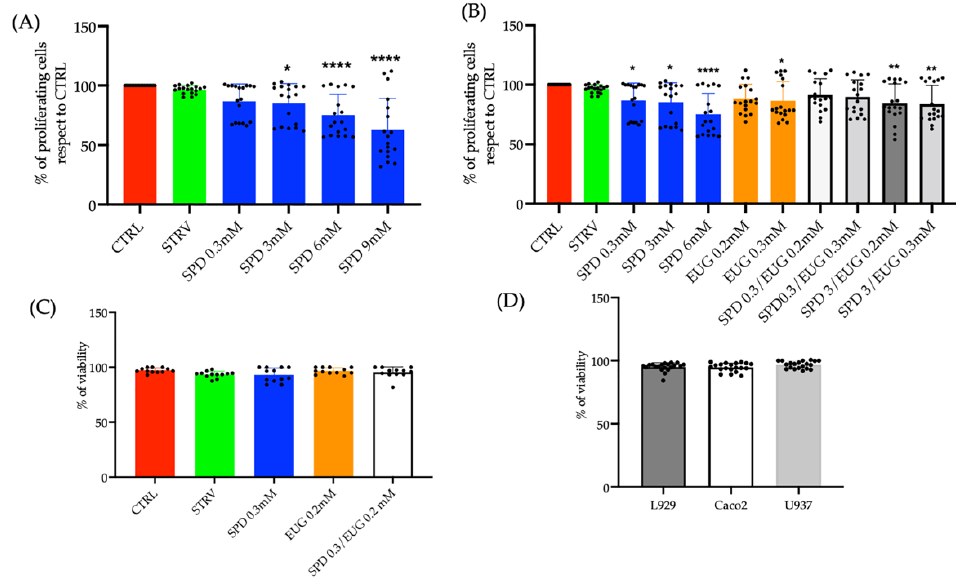
Figure 1. ( A ) Effect of varying spermidine (SPD) concentrations on cellular proliferation in Caco-2, L929 and U939 lines after 24 h, reported as an average response on all three cell lines using the MTT assay. ( B ) Effect of eugenol (EUG) concentration in combination with SPD on Caco-2, L929 and U937 lines after 24 h, reported as an average response using the MTT assay. Comparison was made to the untreated control and starvation-induced cells (STARV). ( C ) The effect on cell viability using the blue trypan exclusion assay after a 24 h exposure to 0.3 mM SPD and 0.2 mM EUG alone and in combination (0.3 mM SPD + 0.2 mM EUG) on Caco-2, L929 and U939 lines expressed as an average response or ( D ) as a response of the individual cell lines. The designation of the number of stars *, ** and **** represents significant differences between treatments as determined by one-way ANOVA at the 99% confidence level ( p < 0.01). The black dots indicate the positioning of the individual replicates within the bar for each sample .